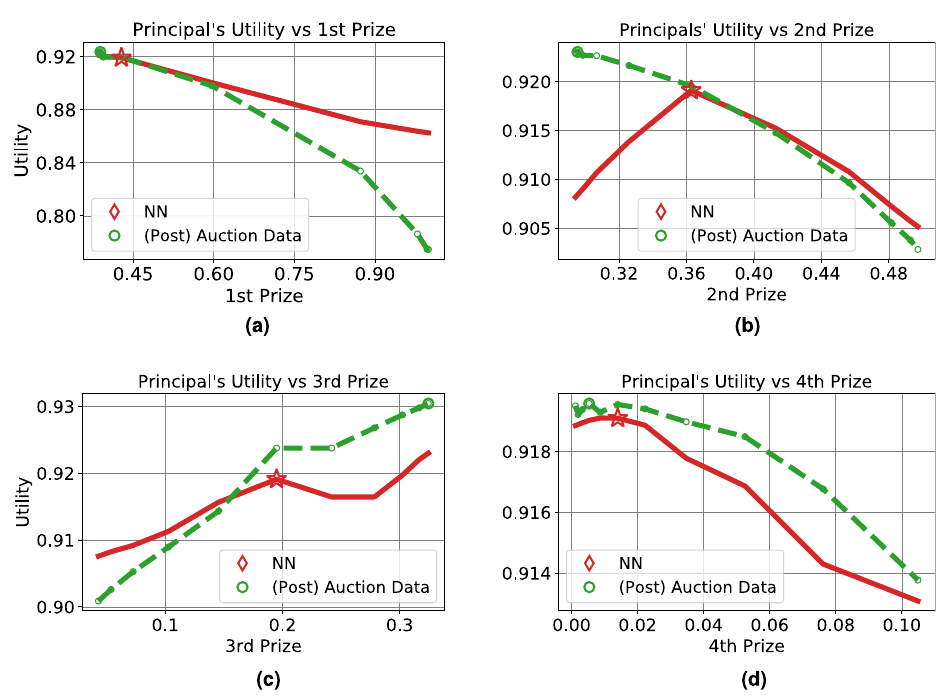
Figure 7. Utility for ten bidder contest vs the top four prizes with realized bids drawn uniformly from bid ± .06 . Plots shown on different scales and slices of the design